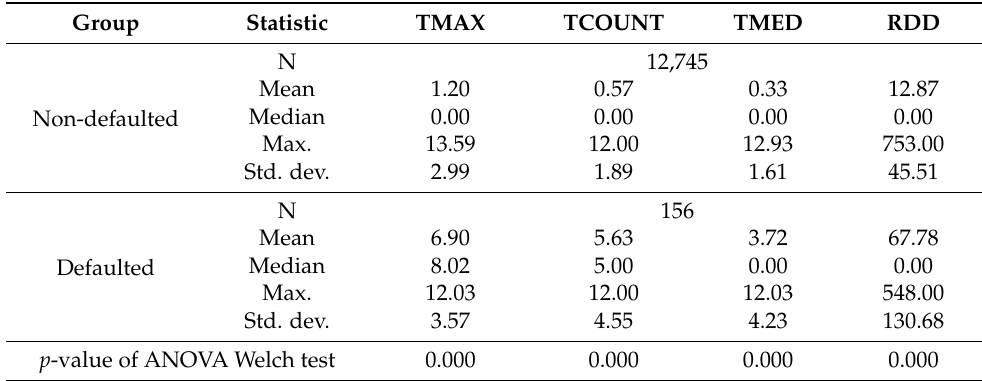
Table 6. Descriptive statistics of non-financial